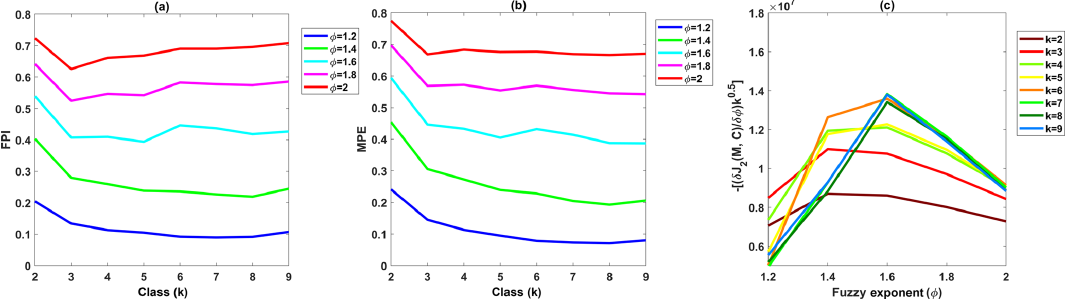
Figure 3. Determination of the number of classes, k , and the fuzzy exponent, φ , for the FKM cloud–aerosol discrimination algorithm: (a) FPI ( y axis) versus class number k ( x axis) for different values of fuzzy exponent φ (different colors); (b) MPE ( y axis) versus class number k ( x axis) for different values of fuzzy exponent φ (different colors); and (c) objective function values ( y axis) versus the fuzzy exponent φ ( x axis) for various class numbers (different